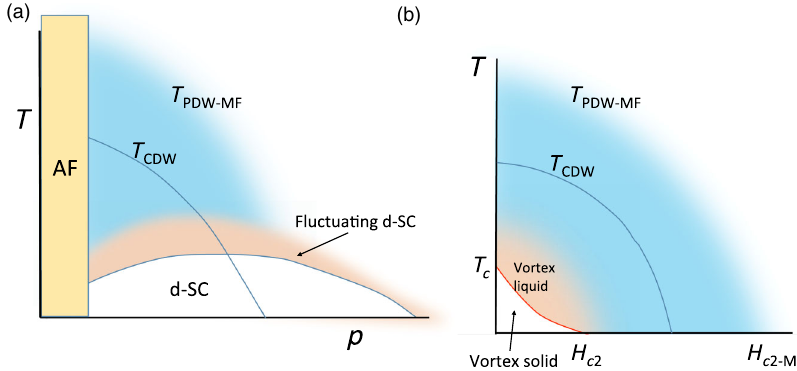
FIG. 7. Proposed phase diagram. (a) T vs doping concentration p . T is a crossover temperature where the pairing amplitude is PDW-MF established. The phase diagram is dominated by the shaded blue region representing PDW superconductivity, which is short-range ordered because of strong phase fluctuation. It is responsible for the pseudogap. CDW order appears below T . In real material, CDW disorder pinning destroys true long-range order. d -wave superconductivity appears below T c , accompanied by fluctuating d -wave superconductivity which is tied to T c . The PDW, either fluctuating or with long-range order, coexists with d -wave pairing up to some doping. The precise location and nature of the antiferromagnetic (AF) boundary depends on disorder. (b) T vs magnetic field H . The red line is the vortex melting temperature that separates the vortex solid from the vortex liquid. At zero temperature for H > H c 2 , vortex cores overlap, resulting in a short-range order PDW state that is metallic and shows quantum oscillations. The CDW order is destroyed beyond a certain magnetic